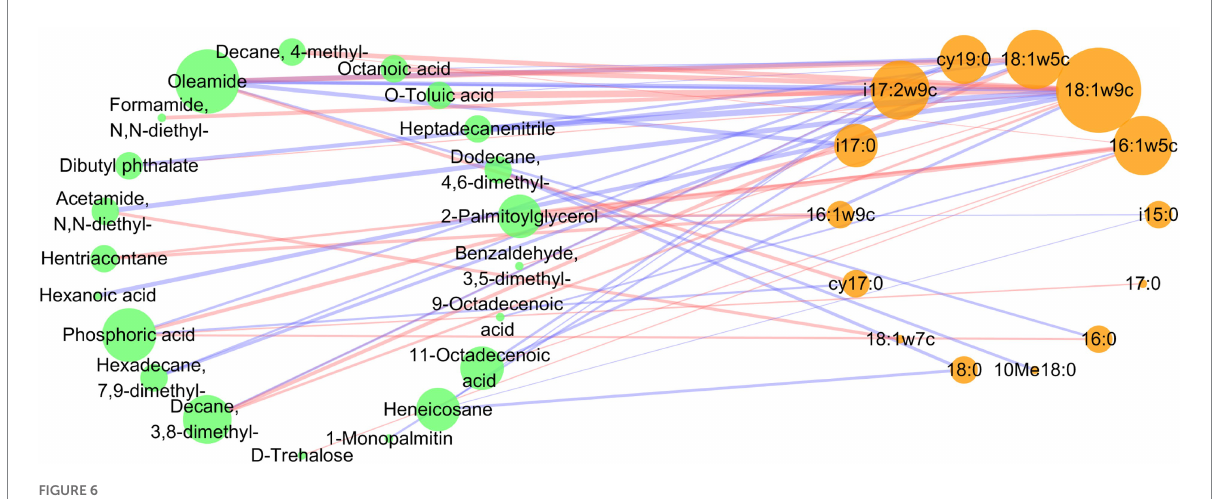
FIGURE 6 Co-occurrence network of the microbial PLFAs and differential metabolites under different fertilization levels. A connection indicates a strong correlation (spearman correlation analysis, p < 0.05), the stronger the spearman correlation, the thicker the line. The size of each node is proportional to the number of connections, the blue and red lines indicate negative and positive relationships, respectively.